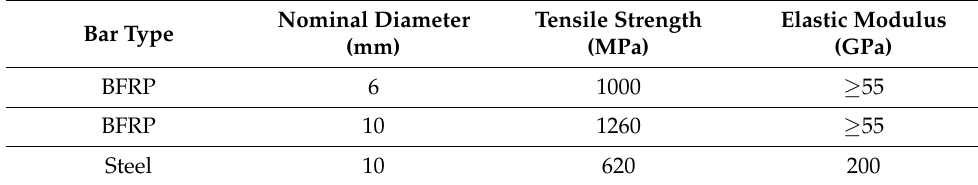
Table 1. Mechanical properties of BFRP and steel bars [1].